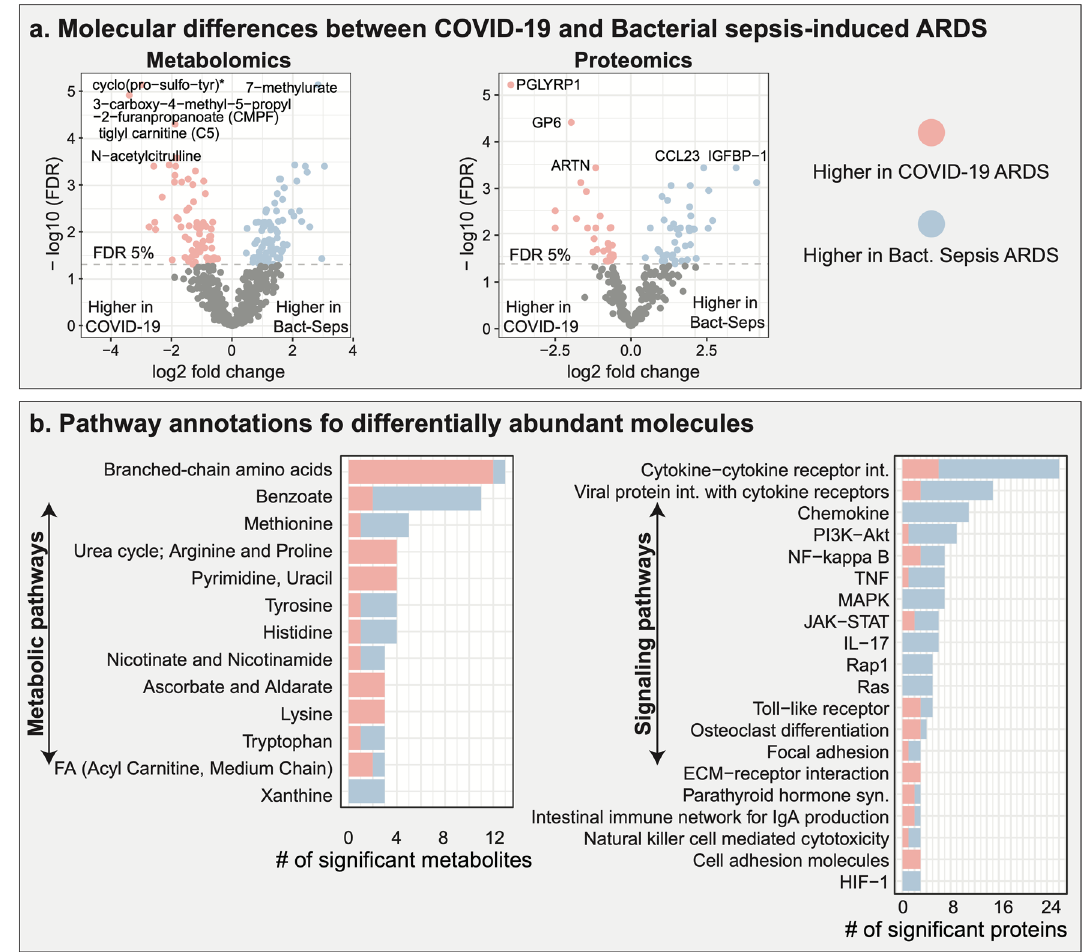
Fig. 1 Molecular signature of COVID‑19 ARDS compared to bacterial sepsis‑induced ARDS. a Differentially abundant molecules (150 metabolites, 70 proteins) between the two ARDS groups. b Functional annotations of differentially abundant metabolites and proteins at the pathway level. Overall, 33 metabolic and signaling pathways with three or more significant molecules were deregulated between the two ARDS groups. FA: fatty